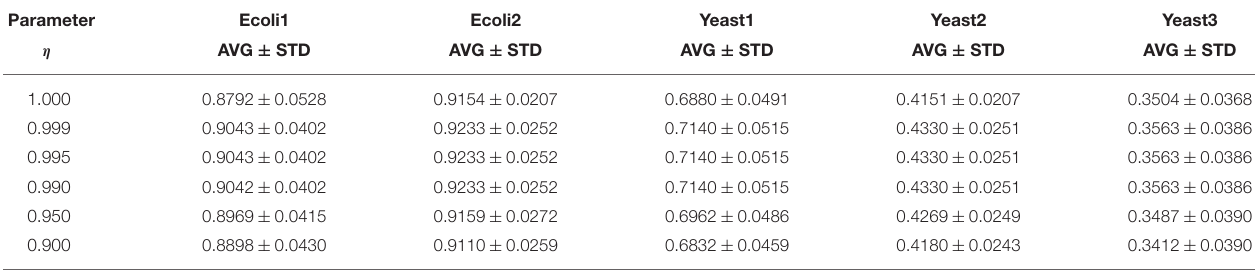
TABLE 2 | The AURPCs of the proposed approach with different values for the parameter η . Parameter